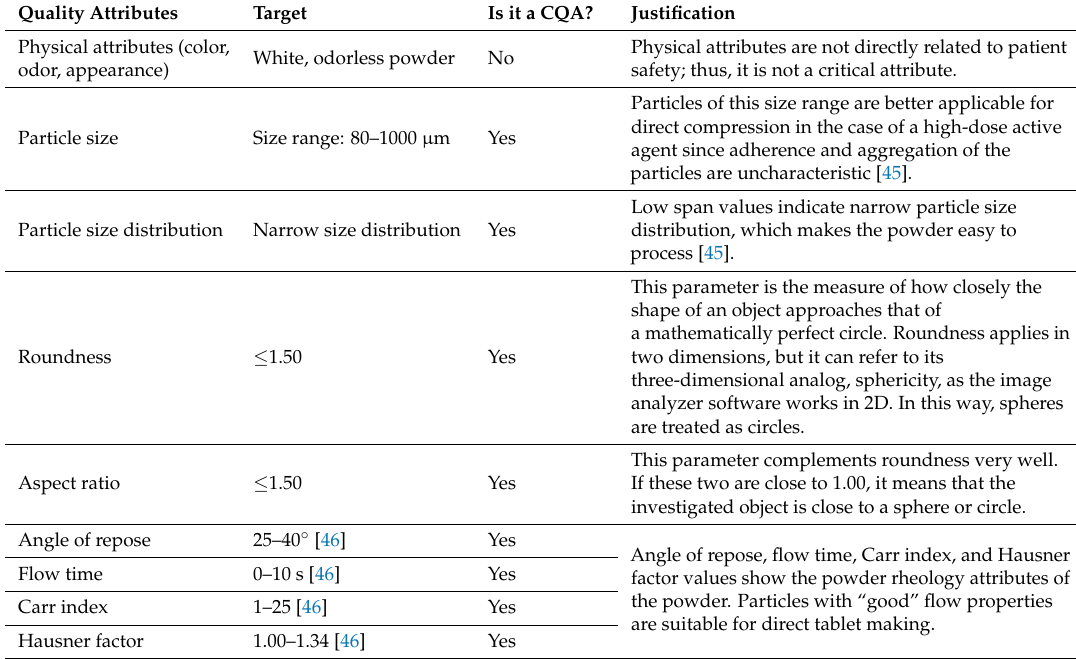
Table 3. Critical quality attributes (CQAs) of the spherical crystal containing AMB